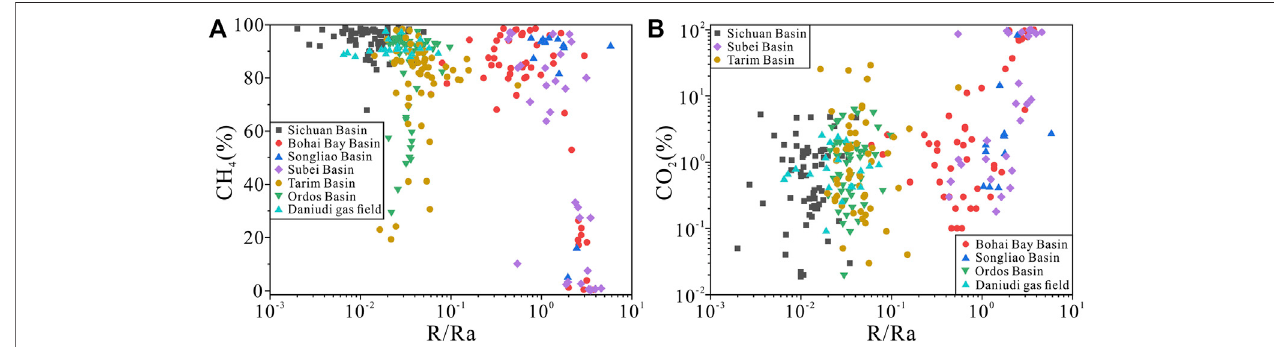
FIGURE 8 | Cross-plots of CH 4 (%) (A) and CO 2 (%) (B) vs . R/Ra of natural gas in the Daniudi gas fi eld and typical petroliferous basins in China.